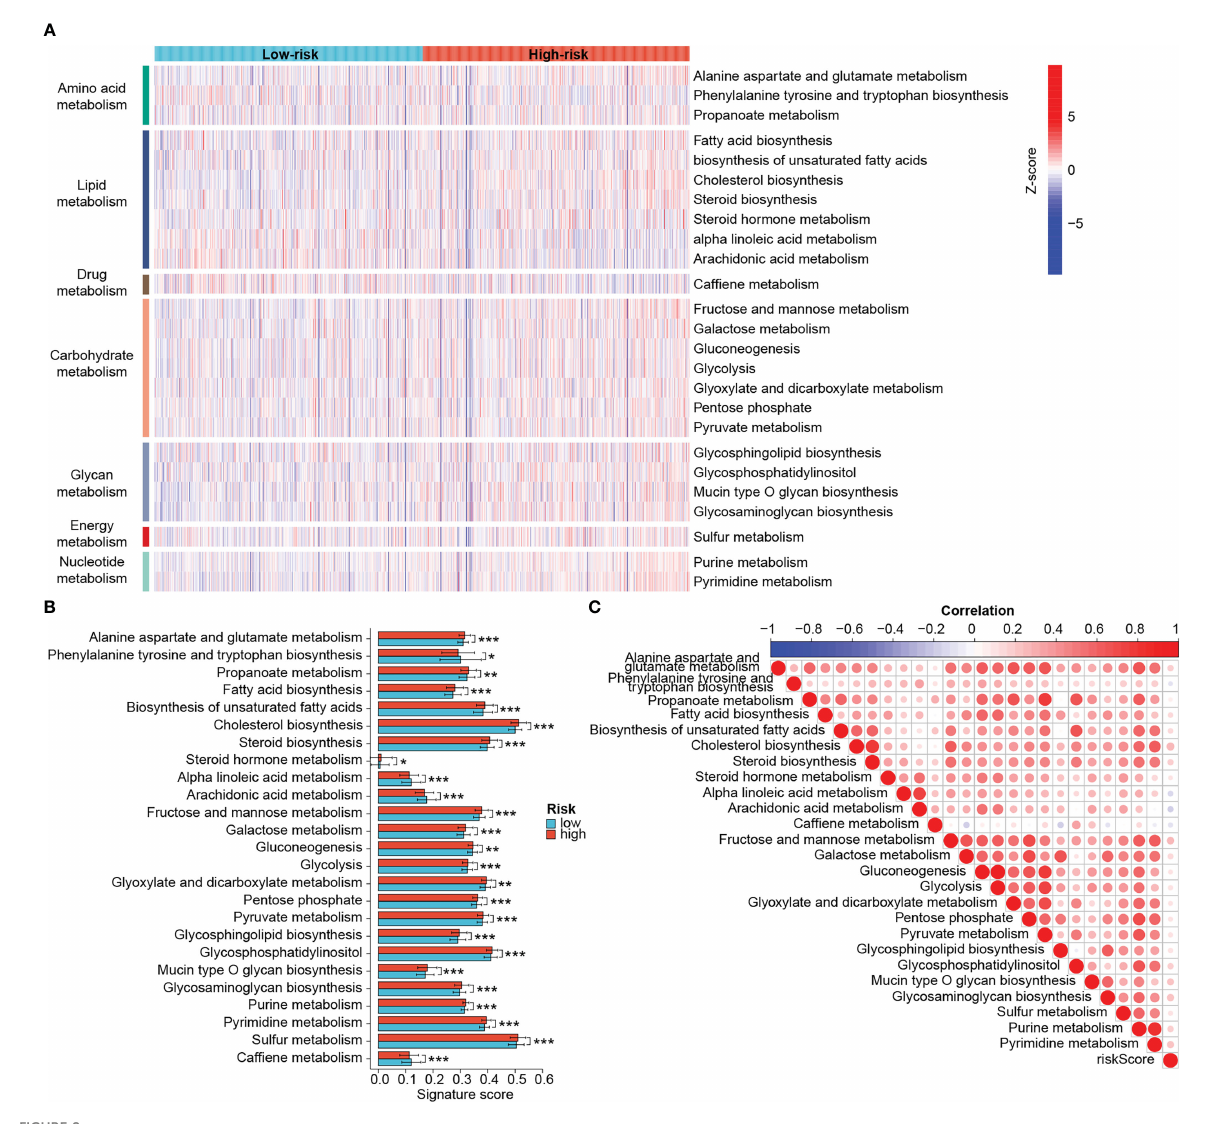
FIGURE 8 Distinct metabolic pro fi les between risk groups. (A) Heat map of different metabolic processes in risk groups. The color from blue to red represents the score from low to high. (B) Differential metabolic processes between risk groups. (C) Heat map of correlation between risk scores and metabolic processes. In this heat map, the size of the circle represents the statistical signi fi cance and the color represents the correlation. The color from blue to red represents the negative to positive correlation. (*P < 0.05, **P < 0.01, ***P <